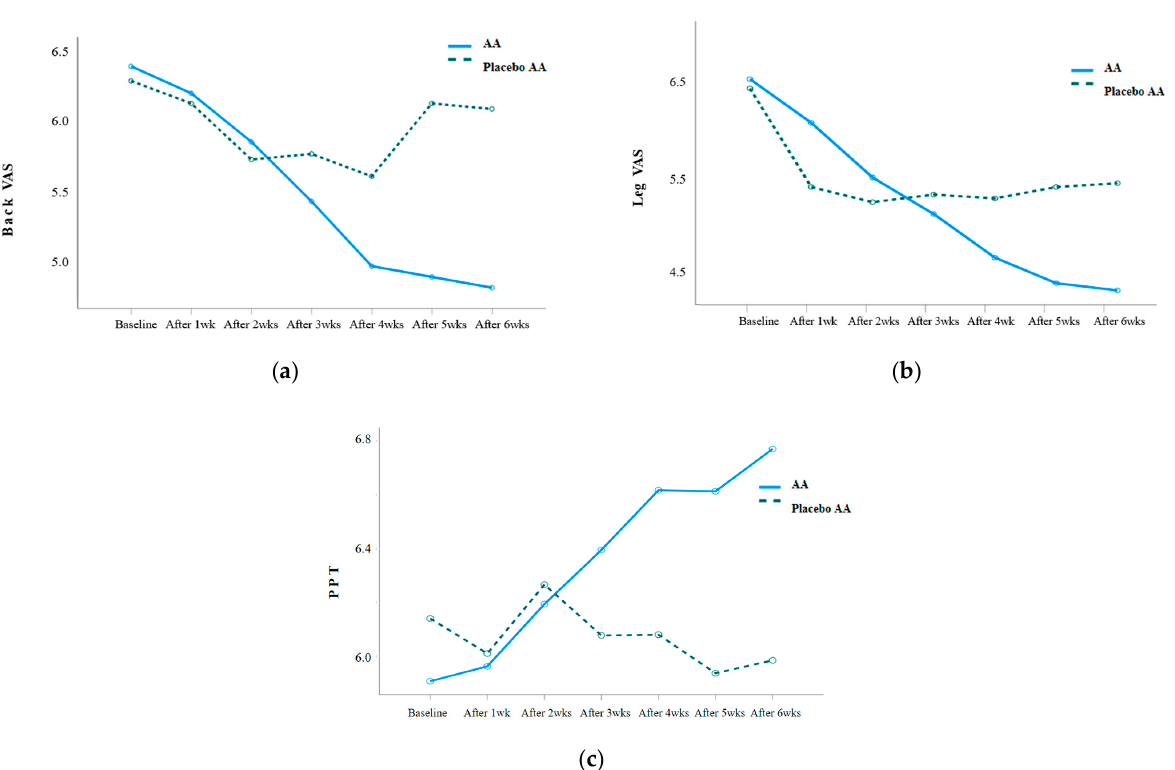
Figure 3. ( a ) Changes in back VAS in the experimental and placebo control groups; ( b ) changes in leg VAS in the experimental and placebo control groups; ( c ) changes in PPT in the experimental and placebo control groups.